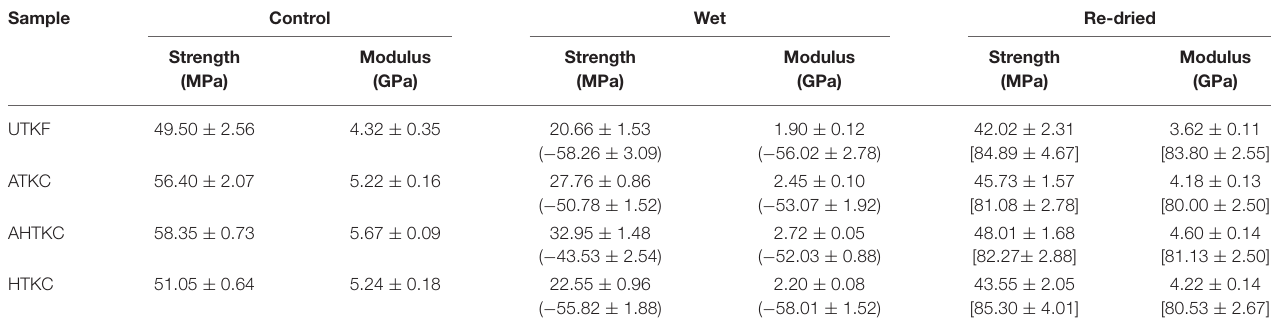
TABLE 6 | Flexural properties of composites before and after subjected to water absorption.